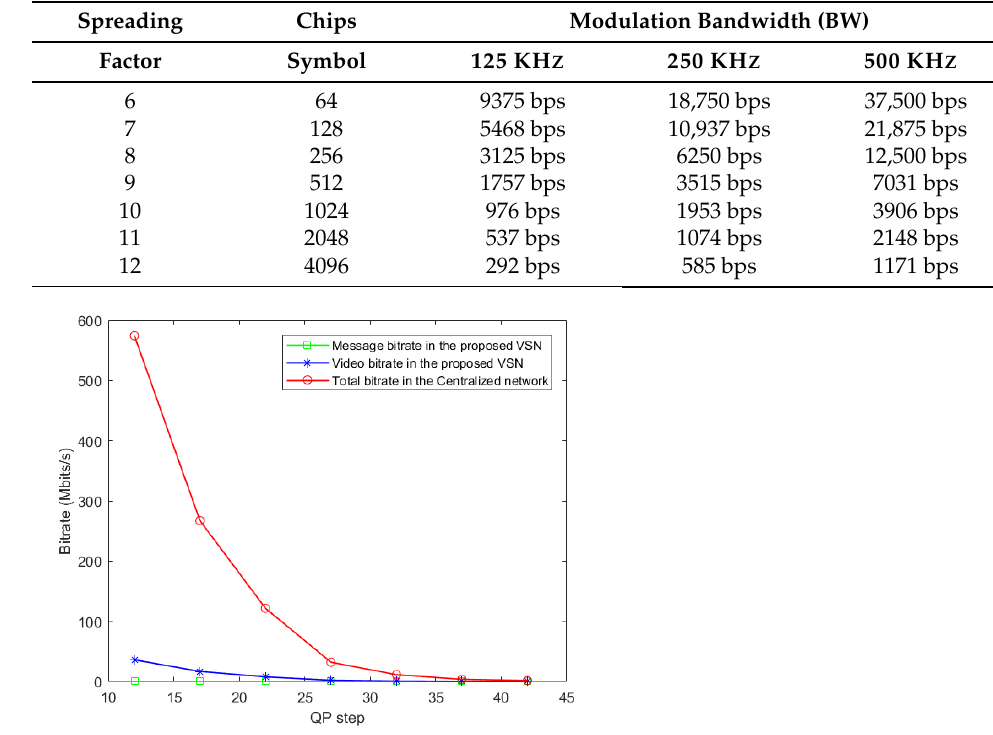
Table 4. LORA bitrates (code rate = 4/5).